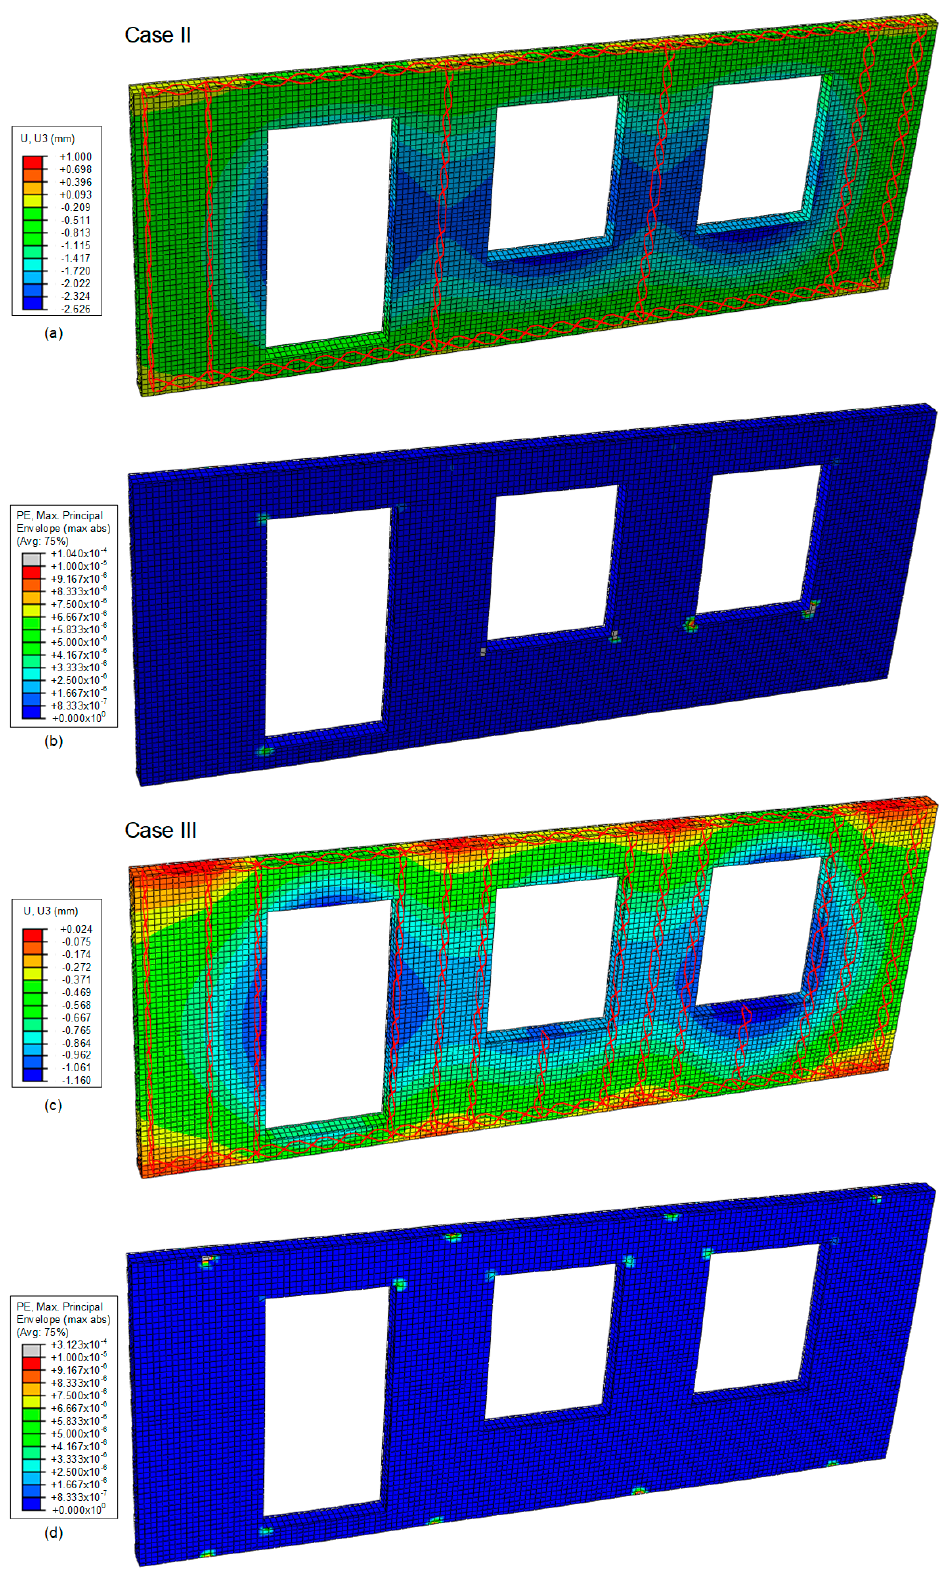
Figure 18. Case II: contour plots of out-of-plane displacement ( a ) and cracked regions at the SLS ( b ); and Case III: contour plots of out-of-plane displacement at the SLS ( c ) and cracked regions at the ULS ( d ).